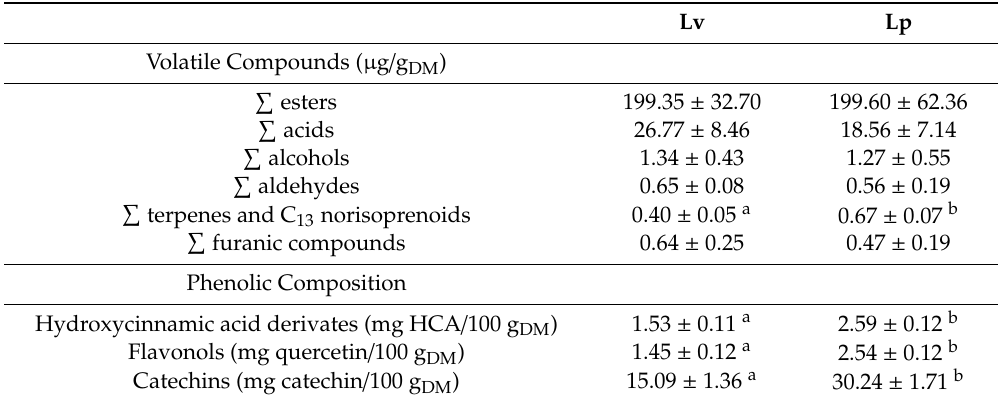
Table 1. Volatile and phenolic composition of wine lees (n = 2) used in the elaboration of the burgers (mean ± standard